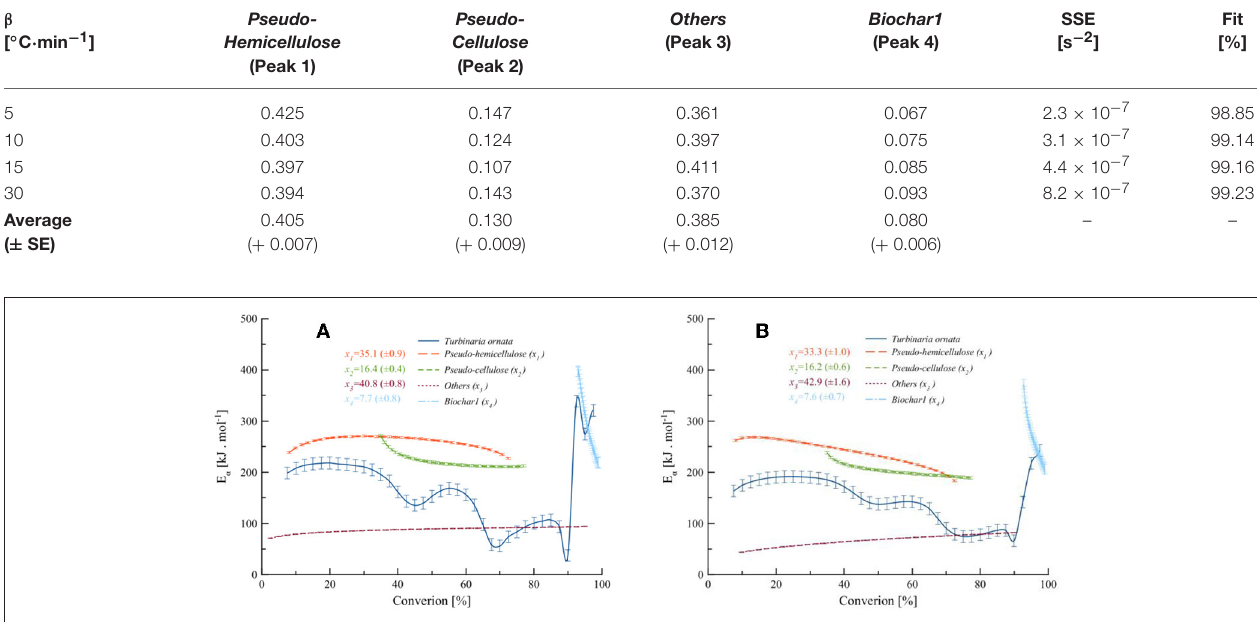
FIGURE 7 | Evolution of activation energies with the conversion from the (A) Friedman method and (B) KAS method.